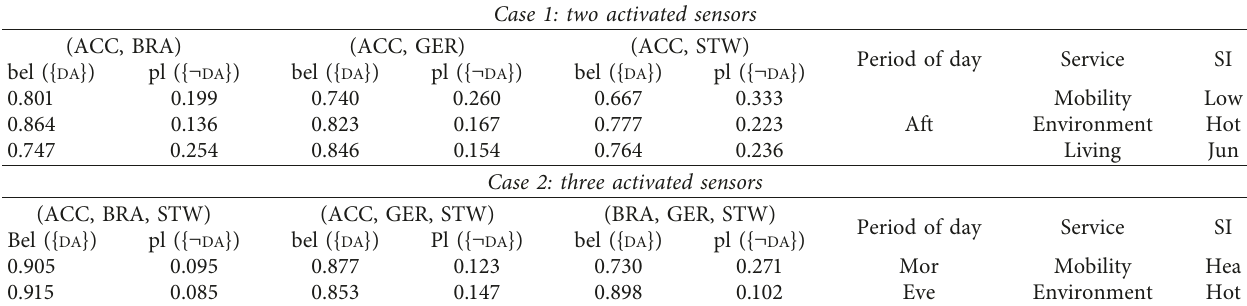
Table 7: Belief values of DA with more activated sensors combined with several services in different scenarios. Case 1: two activated